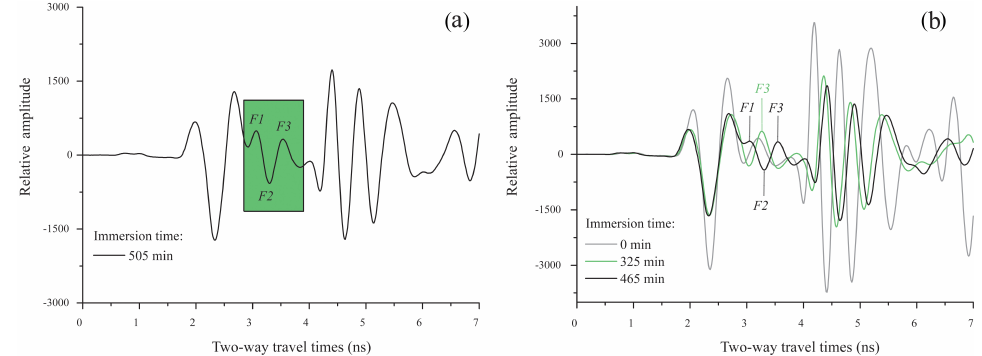
Figure 6. (a) Waterfront reflection maximum peaks; (b) waterfront reflection evolution along immersion time.